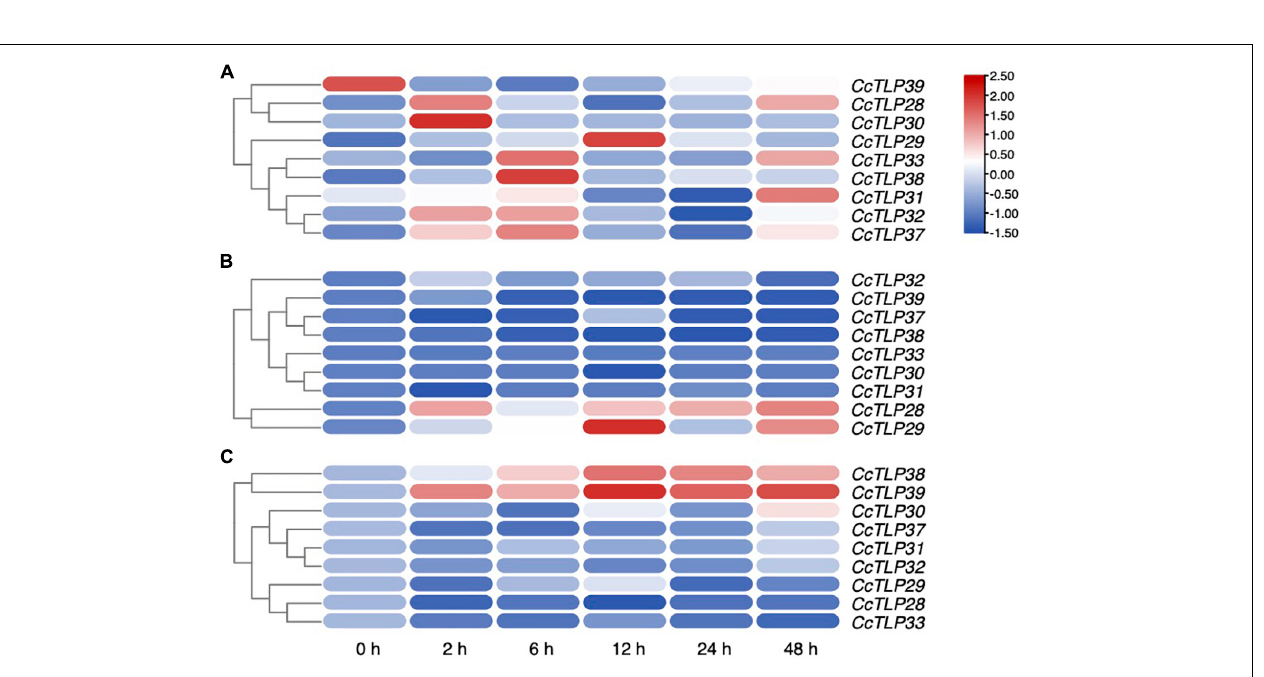
Frontiers in Plant Science |